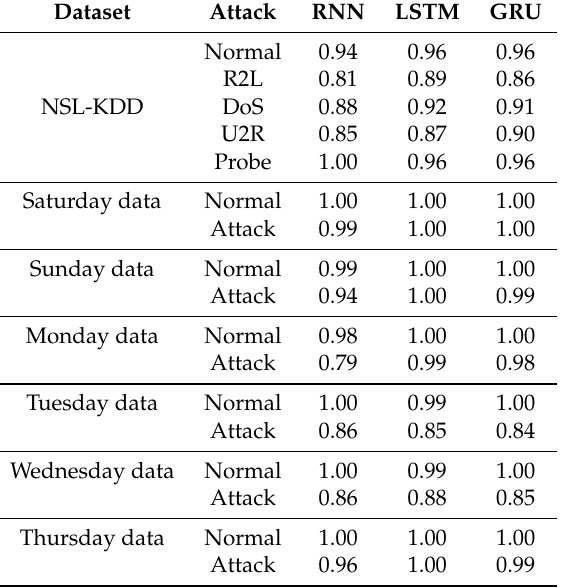
Table 3. The accuracy of attack types detection on two